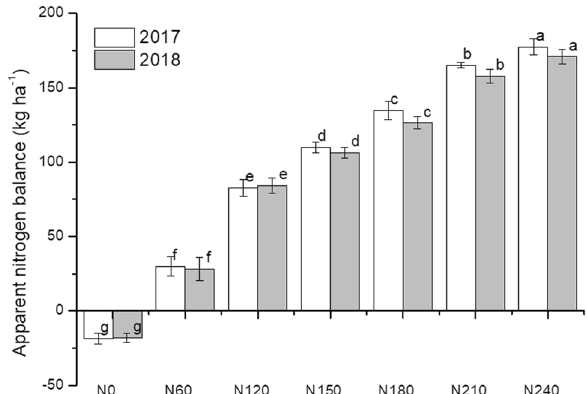
Figure 2. Apparent nitrogen balance (amount of nitrogen input minus amount of plant nitrogen uptake) calculated for potato treated with different nitrogen fertilizer rates. Different letters indicate significant differences (P < 0.05) among treatments in the same year.